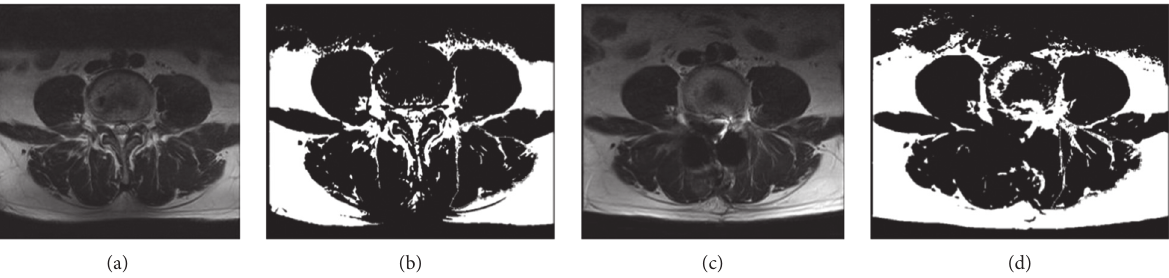
Figure 1: A 45-year-old male patient diagnosed with lumbar spinal stenosis. (a) represents L4-L5 vertebral MRI, while (b) is the same image obtained after processing by the ImageJ software. (c) represents L4-L5 vertebral MRI after CBTsurgery, while (d) is the same image obtained after processing by the ImageJ software. The area enclosed by the yellow line after image thresholding in the ImageJ software is the ES portion of the paravertebral muscle. ES area and FI obtained by calculation using the ImageJ software.